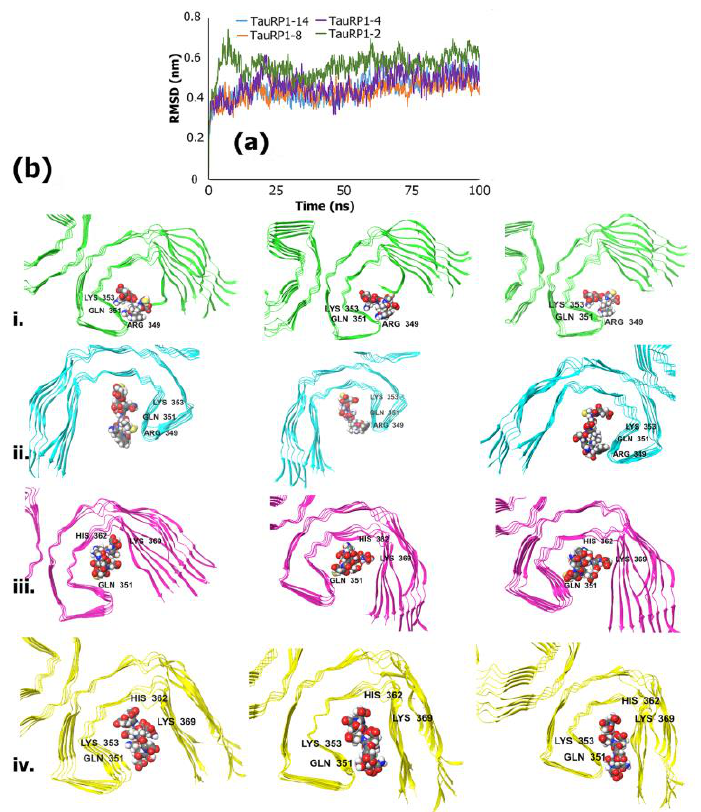
Figure 6. ( a ) Comparison of Cα RMSDs of PHF Tau upon binding to each of the TauRP peptides; ( b ) trajectory images of top three conformers based on clustering obtained at the last 25 ns of simulations from left to right for each ligand with PHF Tau. ( i ) TauRP1-2 with PHF Tau; ( ii ) TauRP 1-4 with PHF Tau; ( iii ) TauRP1-8 with PHF Tau; ( iv ) TauRP1-14 with PHF Tau. The KAWVCDGDND (TauRP1-2) and WVCDGDNDCE (TauRP1-4) peptides